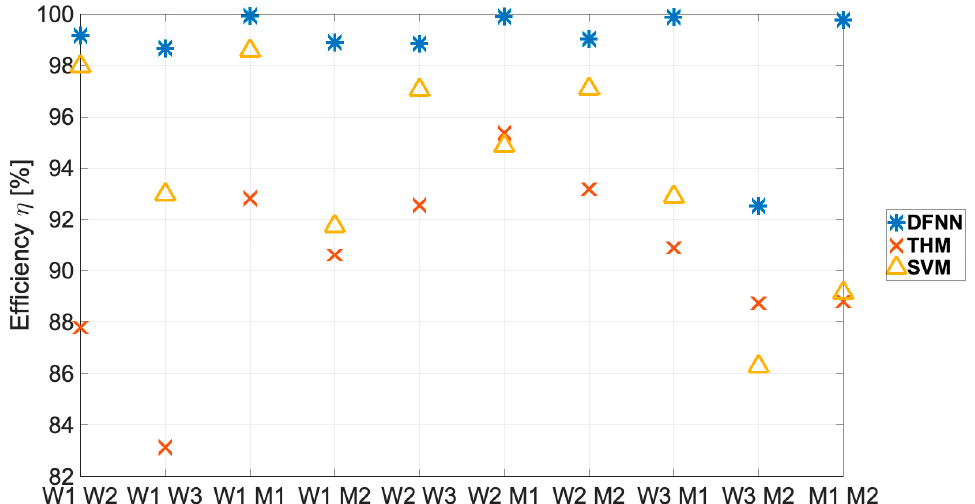
Figure 4. Selected methods effectiveness η for two-person training sets.